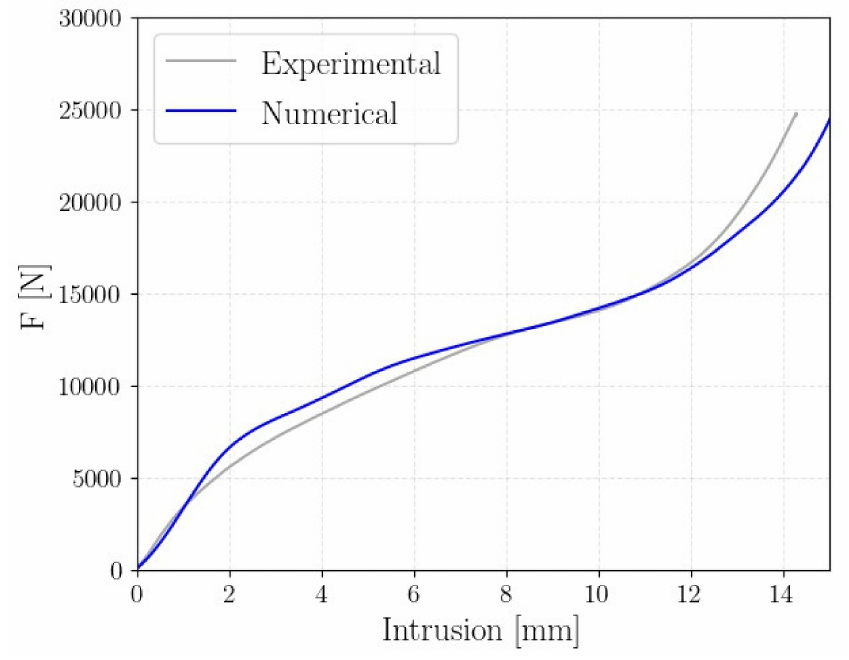
Figure 11. Comparison of the experimental and numerical force–displacement curves of the A4B3 lattice